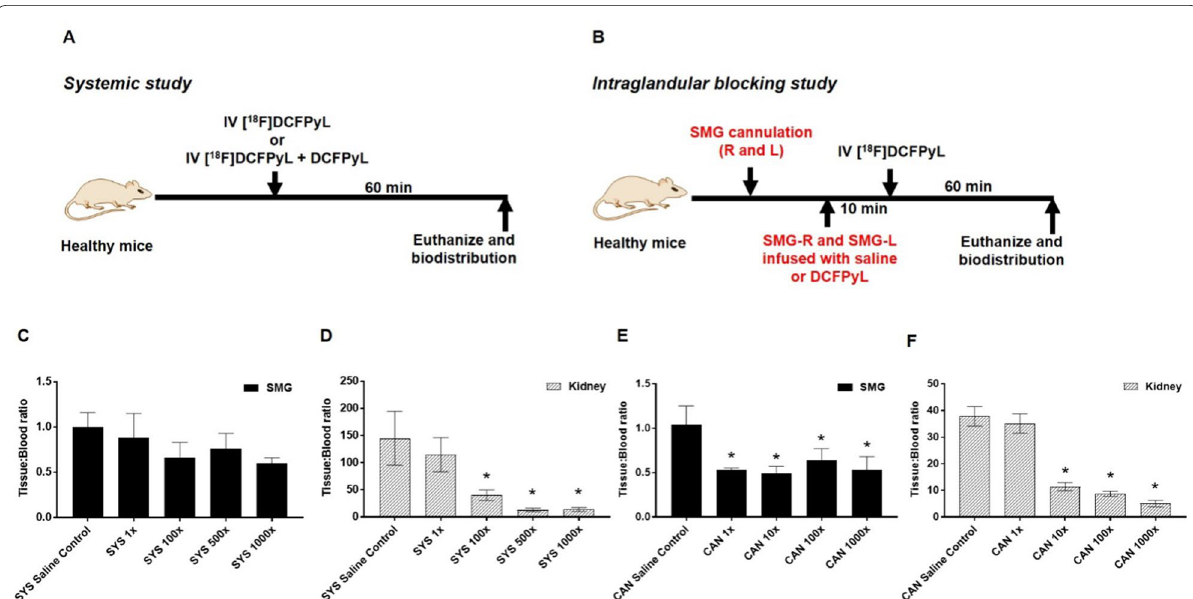
Fig. 2 Experimental design for systemic study (SYS group) and intraglandular blocking study (CAN group) for the dose-finding in non-tumor-bearing cohort ( a , b ). The tissue/blood ratios of [ 18 F]DCFPyL in submandibular salivary glands (SMG) and kidney at 1 h post-injection are shown for the SYS group (panels c , d ) and for the CAN group (panels e , f ), respectively. Mice were injected either with 50 µl of saline control or with DCFPyL at 1 to 1000 molar equivalent of the systemically injected [ 18 F]DCFPyL dose. Each value in the graphs represents mean tissue/blood × × ratios SD, n 5–6 for each group, with statistically significant results ( P < 0.05) indicated by asterisk. The CAN 1 ± = blocking at the SMG and lack of blocking at the kidneys (tumor surrogate). However, unexpected blocking of the kidneys is seen in the CAN group at the 10–1000 level, perhaps due to “leakage” of DCFPyL from intraglandular administration into the systemic ×